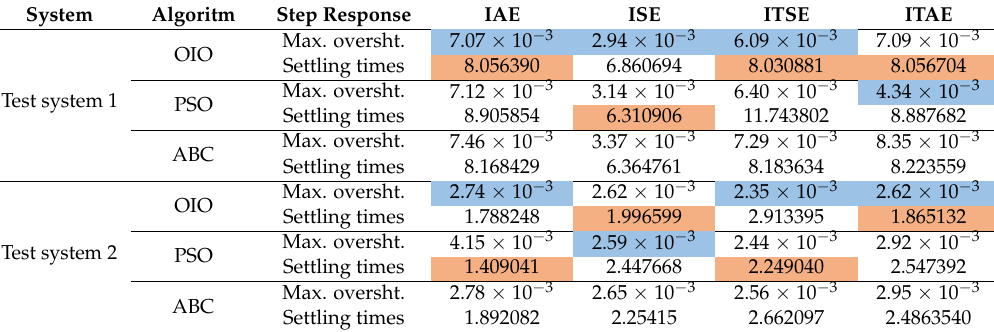
Table 3. Settling times and maximum overshoots (max. oversht.) of the frequency deviation of the control area-1.